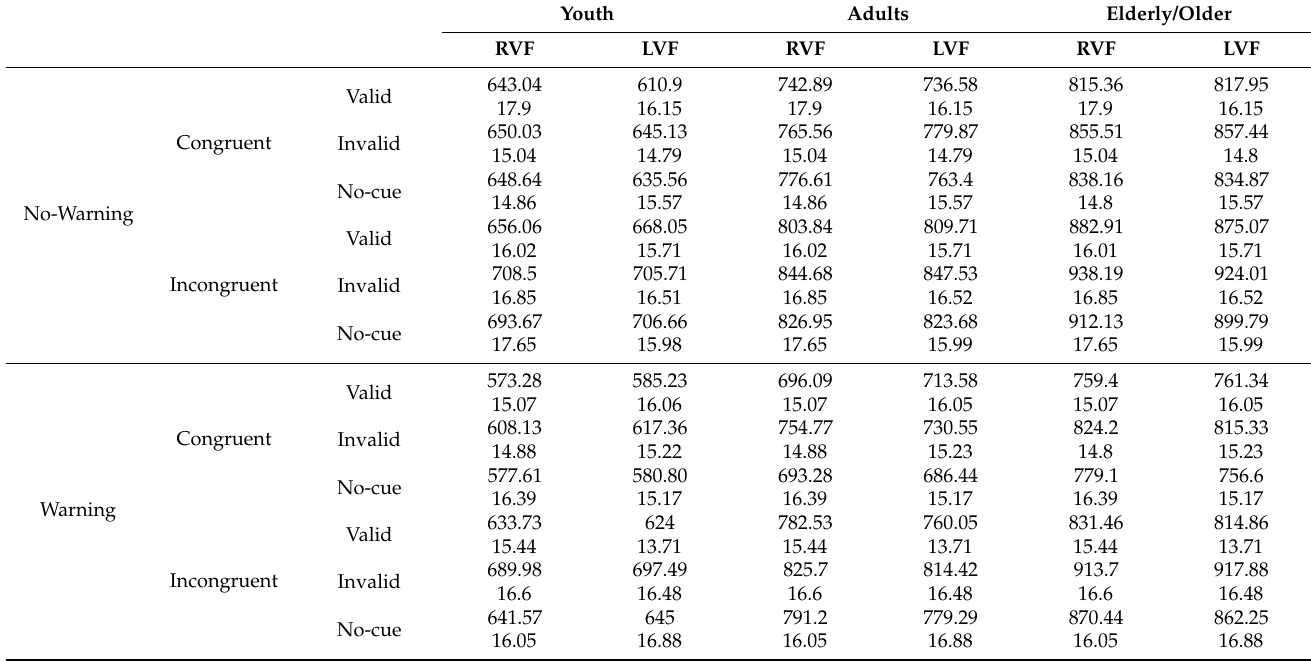
Table 2. Mean reaction times (in ms) and standard deviations of the three age groups of participants for each condition and each visual